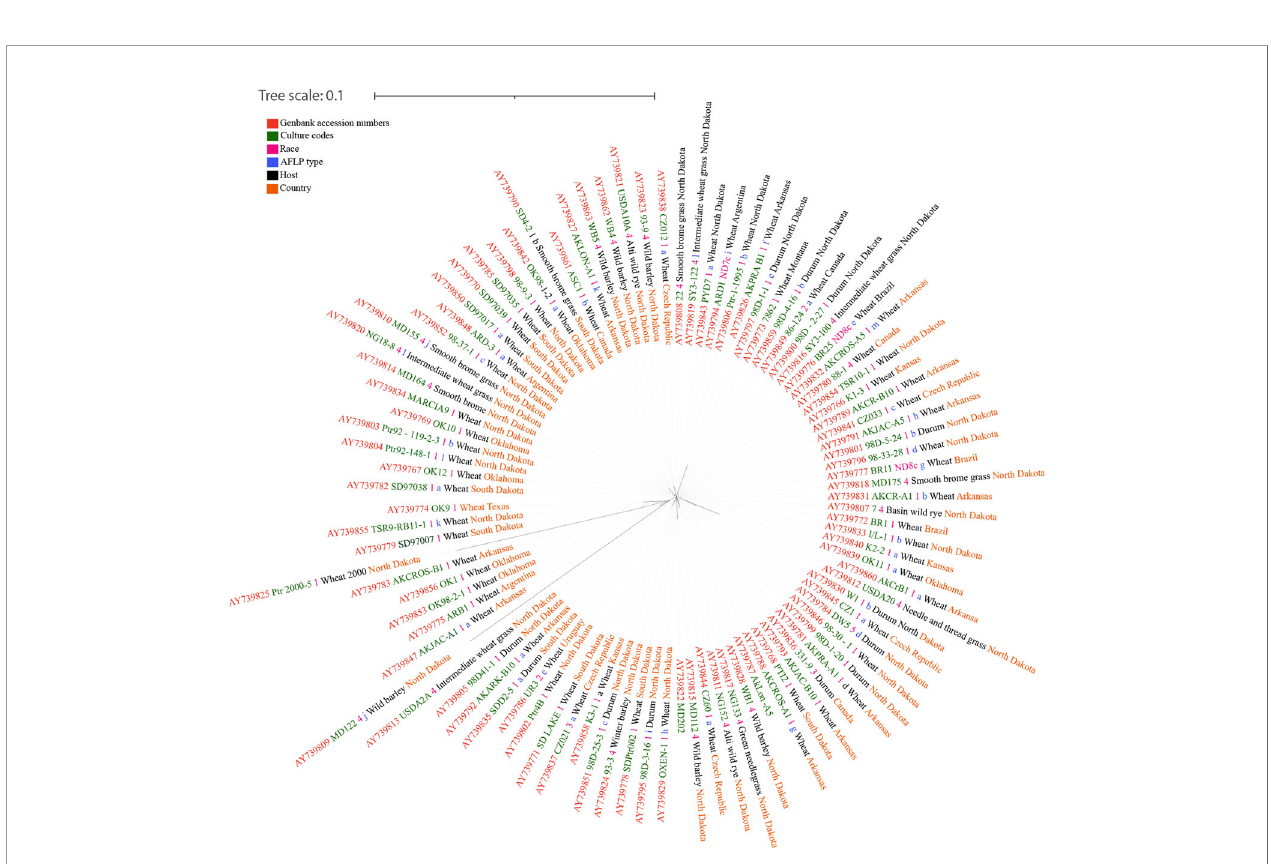
FIGURE 2 | The unrooted RAxML bipartion unrooted phylogenetic tree of Pyrenophora tritici-repentis based on Friesen et al.